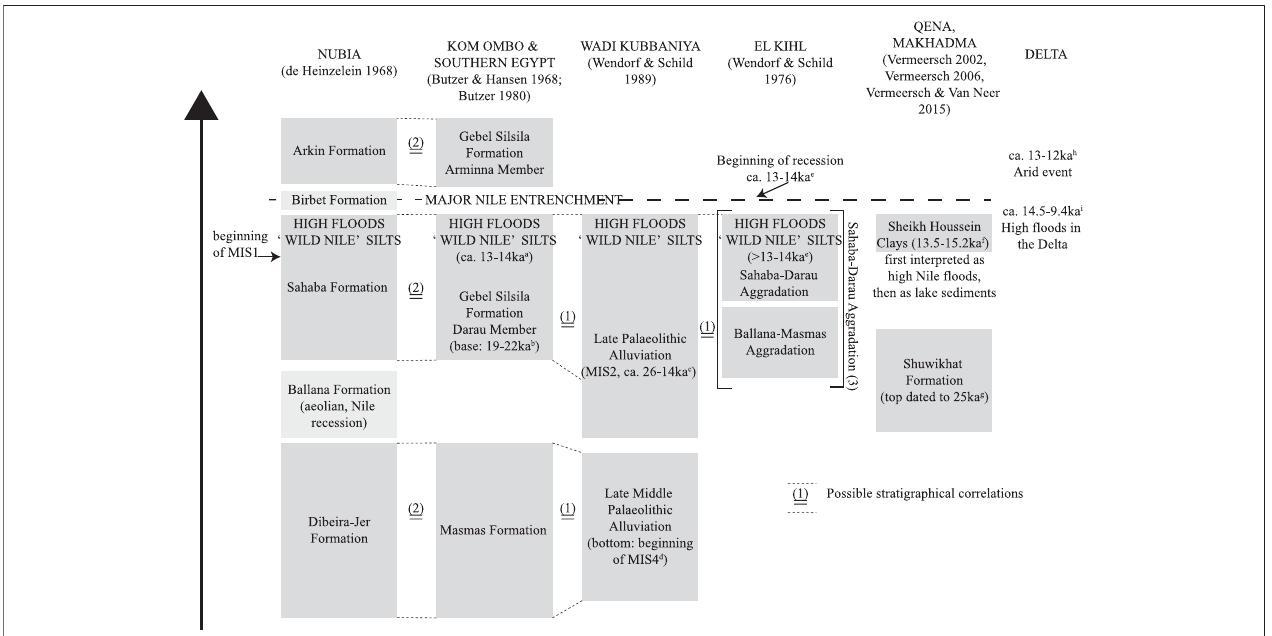
FIGURE 2 | Overview of main geological formations and their proposed correlations in the Lower Egyptian Nile Valley. All dates in the fi gure are in cal BP and were calibrated with two sigma ranges using Intcal20 (Reimer et al., 2020) for terrestrial or Marine20 (Heaton et al., 2020) for marine samples and Calib v. 8.1.0 (Stuiver and Reimer, 1993) 1) Correlations proposed in Wendorf and Schild (1989) 2) Correlations proposed in Butzer and Hansen (1968) and Butzer (1980) 3) Proposed name in Paulissen and Vermeersch, 1987, 46 a Dark silts at New Ballana I dated to 11,720 ± 195 BP (Hv-1264) and 12,000 ± 120 BP (Y-1446) (Butzer and Hansen, 1968), 115) but they are uncorrected for fractionation and may be too young (Butzer, 1997), 161) b Date of the base of the Gebel Silsila Formation at Kom Ombo, dated to 17,000 ± 600BP(I-297)(Butzer and Hansen,1968),114) c Thebase oftheLatePalaeolithic Alluviation at WadiKubbaniyaisdatedto20,690 ± 280BP(SMU-1037) and thetopto12,430 ± 100BP(SMU-1032) (Haas, 1989) d ThechronologicalattributionoftheLateMiddlePalaeolithic Alluviationisdiscussedindetailin(Schildetal.,2020) eThe beginning of the recession of the Nile at the site E71P5 (Late Isnan) at El Kihl is dated to 11,560 ± 180 BP (I-3760) (Wendorf and Schild, 1976, 179), which means that the preceding high fl oods documented at the area must be older f The Sheikh Houssein Clays (Paulissen and Vermeersch, 2000; Van Neer et al., 2000) are dated between 12,570 ± 80 BP (GrN-12033) and 12,060 ± 280 BP (GrN-12029). g Burnt clay from the Shuwikhat Formation (Paulissen and Vermeersch, 2000) was dated by thermoluminescence (Vermeersch et al., 2000) to 25,000 ± 2500 BP (Ox85TLi), which is considered as a minimum age (Vermeersch, 2020). h Isotope data from marine coreMS27PTindicatinganaridepisodebetween10,835 ± 40BP(correctedage,SacA16516)and11,495 ± 40BP(correctedage,SacA16517)(Reveletal.,2015).NB: these ages were calibrated using the Marine20 curve. i Sedimentary features in cores from the Nile deep-sea turbidite system indicate high Nile fl oods during early MIS1. Thechronologicalrangegivenisbasedontwodatesfromcore84MD637(Ducassouetal.,2007;Ducassouetal.,2009);12,670 ±